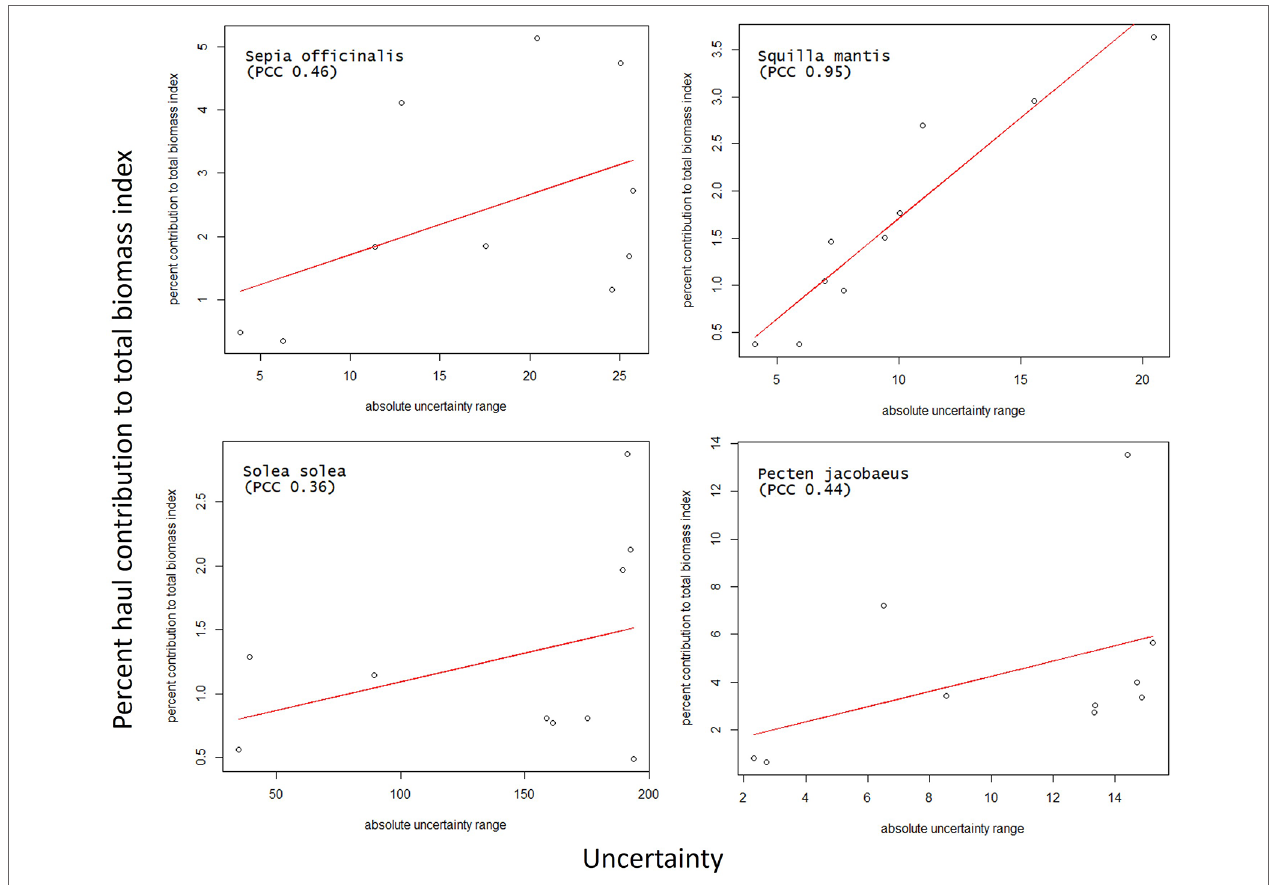
FIGURE 7 | Linear fit between the HBIE 2020 model uncertainty and the percent haul contribution to the total biomass, with the indication of the Pearson Correlation Coefficient